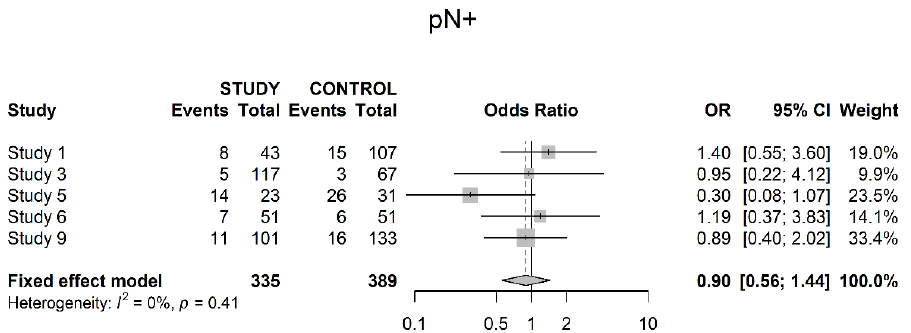
Figure 6. Pathologically positive locoregional lymph nodes.